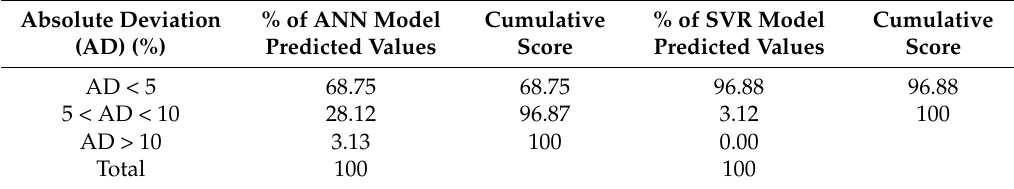
Table 7. Percentage of predicted data points for the heat transfer coefficient of R600a via the ANN-based and SVR-based model in terms of absolute deviation for test (unseen)